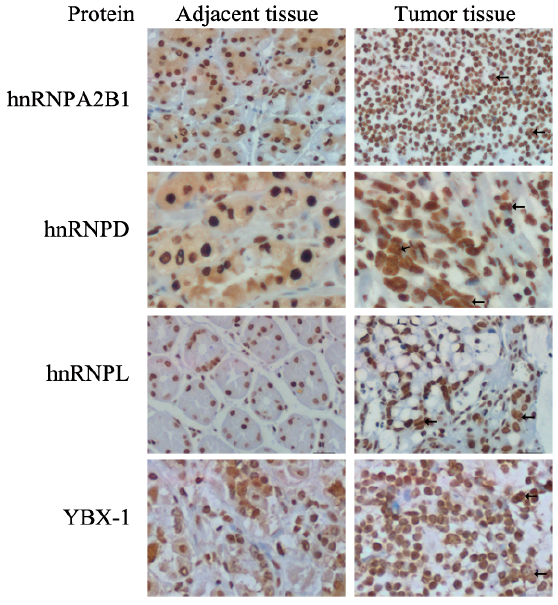
Figure 6. Representative immunohistochemical staining for sectioned formalin fixed GC and adjacent tissues. Specific antibodies of Anti-hnRNPA2B1 (Santa Cruz, TX, USA), Anti-hnRNPD (Proteintech, Chicago, IL, USA), Anti-hnRNPL (Santa Cruz) and Anti-YBX-1 (Santa Cruz) were hybridized respectively. IHC results showed that the morphology of tubular glands disappeared in cancer sections when compared to adjacent tissues. Cancer sections have stronger and higher density nuclei staining, high ratios of nucleus/cytoplasmic area, different shaped nuclei including megakaryocytes and polykaryocytes (arrows). Weak cytoplasmic staining were only seen in hnRNPA2B1, hnRNPD and YBX-1 hybridized normal sections. The magnification is 400×; scale bar: 20 μ m.